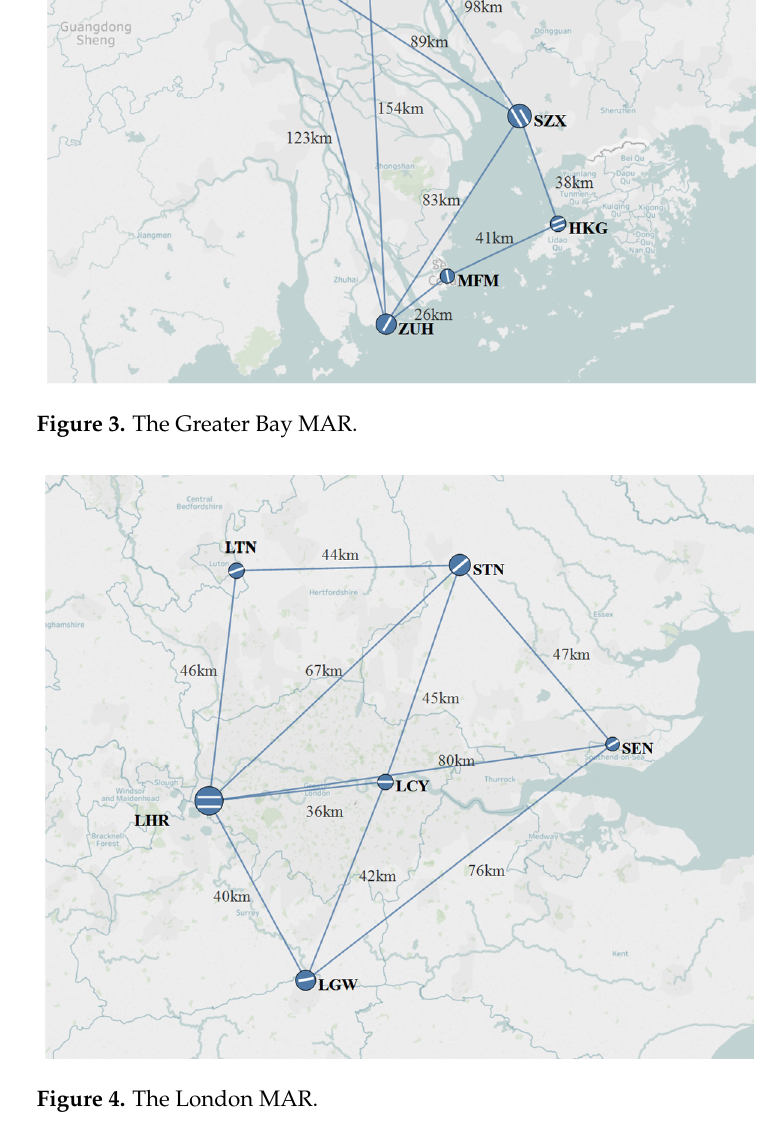
Figure 5. The New York MAR. 5.2. Indicator Weight Analysis The normalization method was used for dimensionless processing in the first layer. Maximum and minimum normalization was employed, as shown in formula (8):  